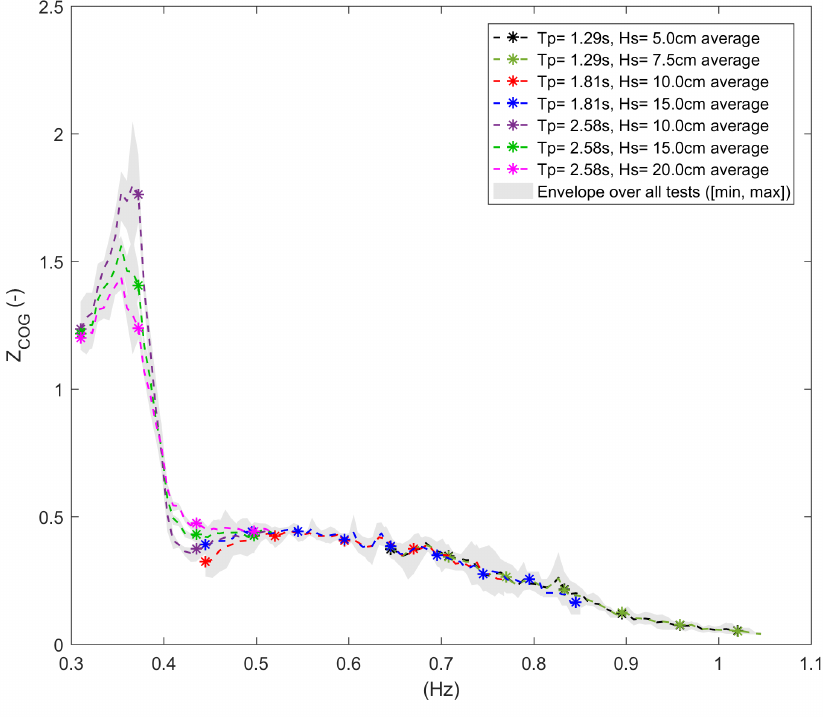
Figure 16. Heave RAOs for all JONSWAP waves: average and envelope (min and